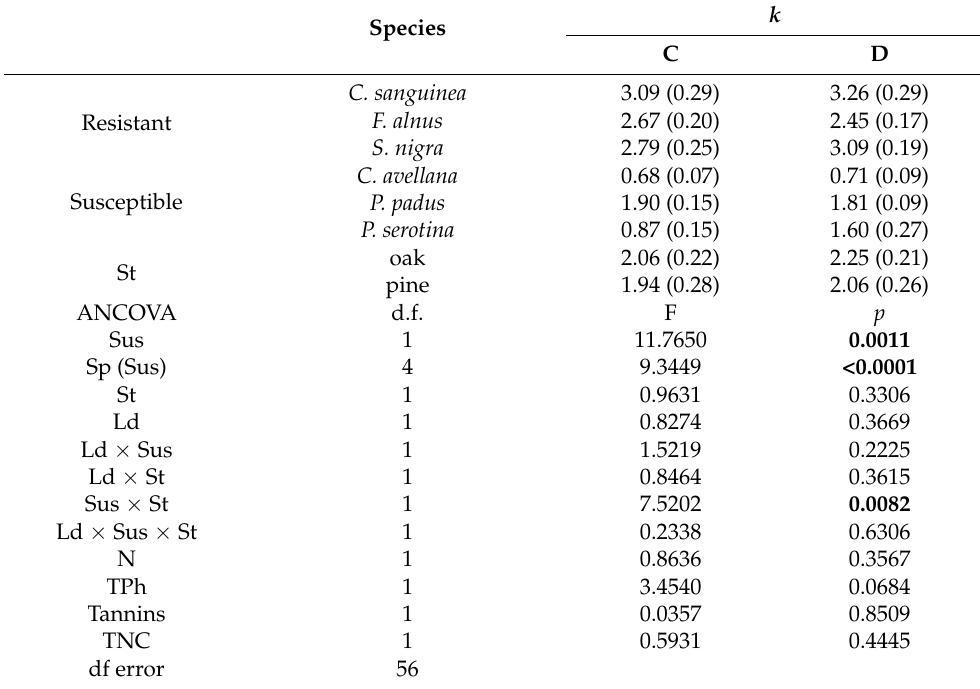
Table 1. Mean litter decay rate ( k ) with standard errors (SE) are presented in first part of table. In the second part are ANCOVA results for the influence of susceptibility to herbivores (Sus; resistant and susceptible), plant species (Sp) nested in Sus, stand species (St; oak and pine), leaf damage (Ld; C, control; D, damaged), and initial content of nitrogen (N), total phenolic compounds (TPh), tannins, and total nonstructural carbohydrates (TNC) on litter decay rate ( k ). p -values < 0.05 are indicated in bold.